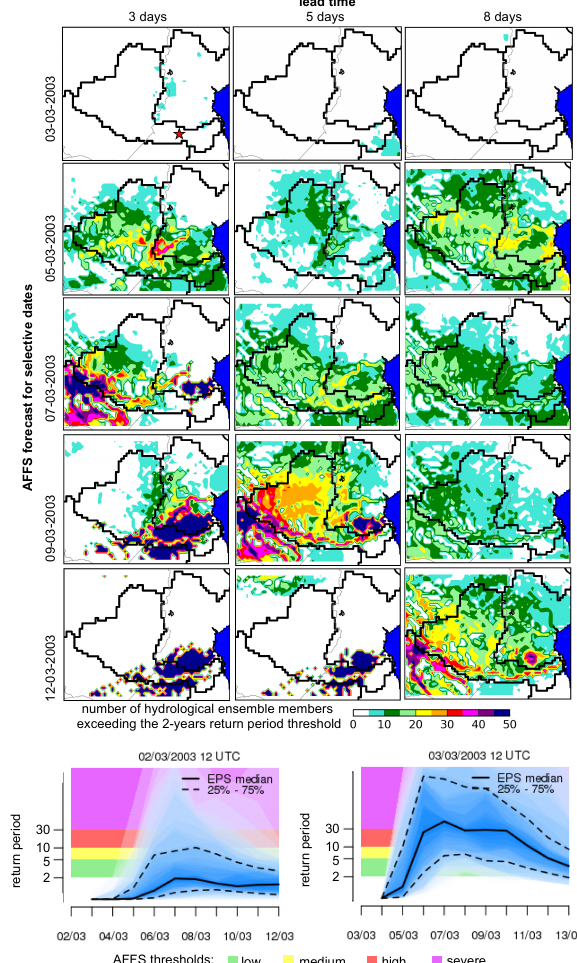
Figure 10. AFFS forecast of the March flooding in the Sabi Basin (102000km 2 ); (a) shows the threshold exceedance maps for a num- ber of selective forecasted days and lead times; while the ensemble quantile plots in (b) show the temporal development of the AFFS forecast for a specific key location (for the location, see the red star in the upper left panel of (a)